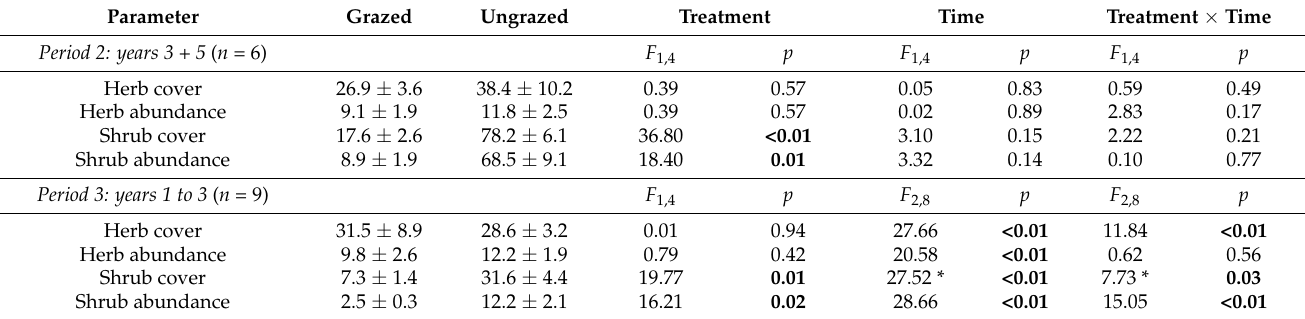
Table 5. Overall mean ( n = 3 × 2; 3 × 3; sites × years) ± SE cover (m 2 /0.01 ha) and abundance (m 3 /0.01 ha) of early seral vegetation (herb and shrub layers) in grazed and ungrazed clearcut sites for comparable years post-harvest for the CC-GR study in southern BC, Canada, and results of RM-ANOVA, and univariate ANOVA where applicable. F -values identified by * were calculated using an H-F correction factor, which decreased the stated degrees of freedom due to correlation among repeated measures. Significant values are given in bold text.